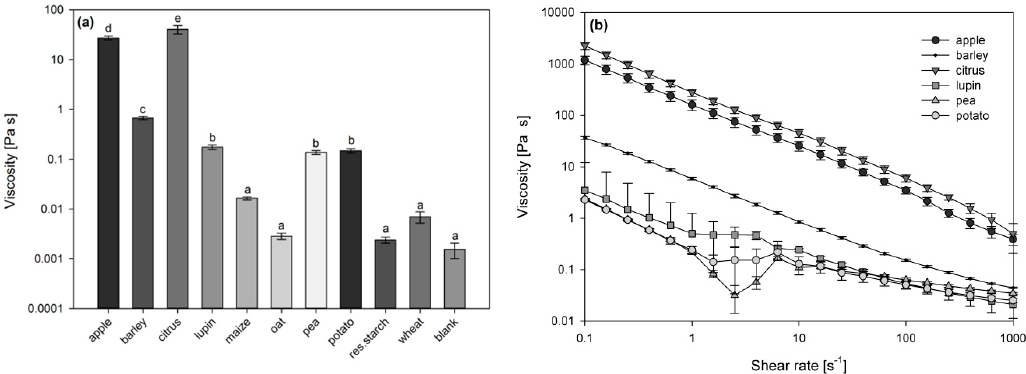
Figure 2. Comparison of viscosity at shear rate 15 s -1 ( a ) and viscosity as a function of the shear rate ( b ) of in vitro digested dietary fibre enriched food ingredients derived from different sources. Different letters indicate significant differences on a p ≤ 0.05 level basis ( n = 3).